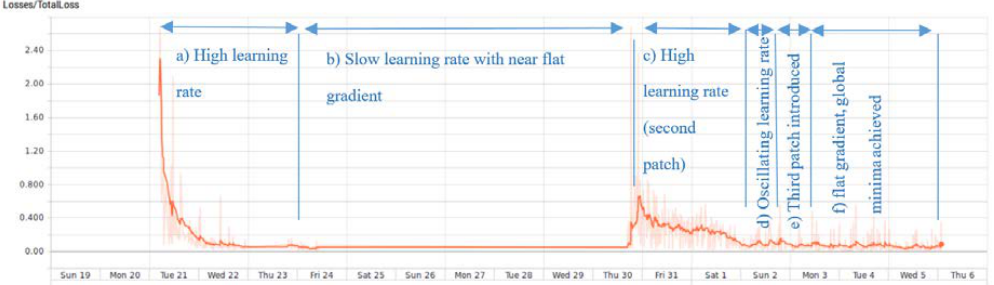
Figure 5. Loss function vs. time during network training until learning step 28330.